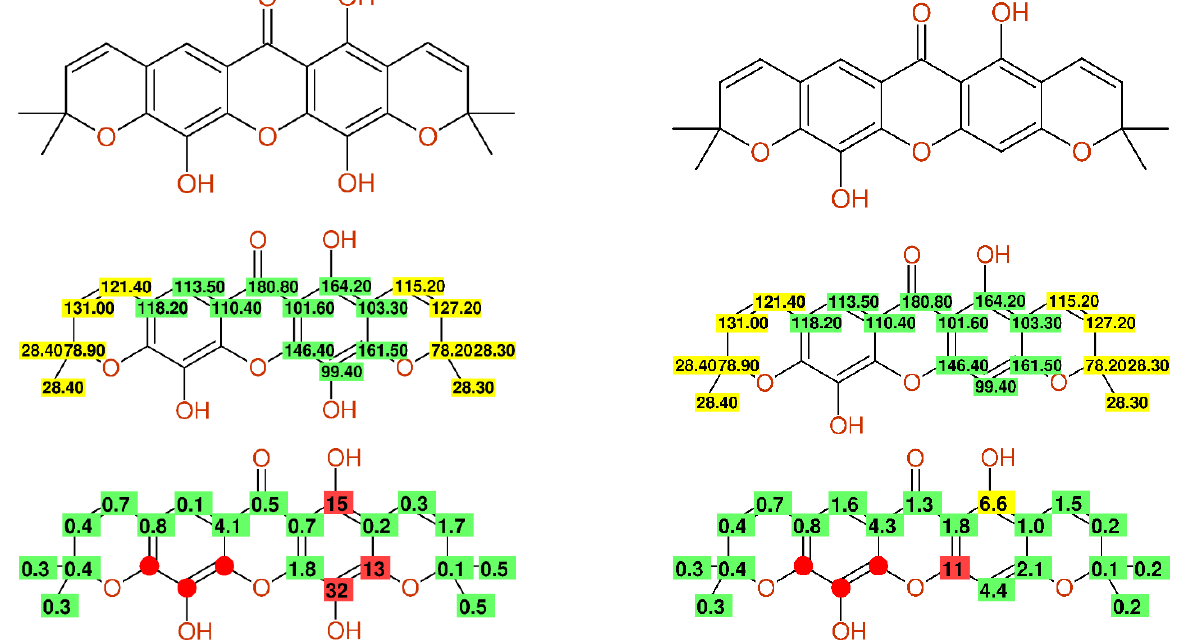
Figure 10. The data of compound 3 from [53] named pyrojacareubine, as published ( left ) and after correction of the structure ( right ), still holding additional assignment errors.